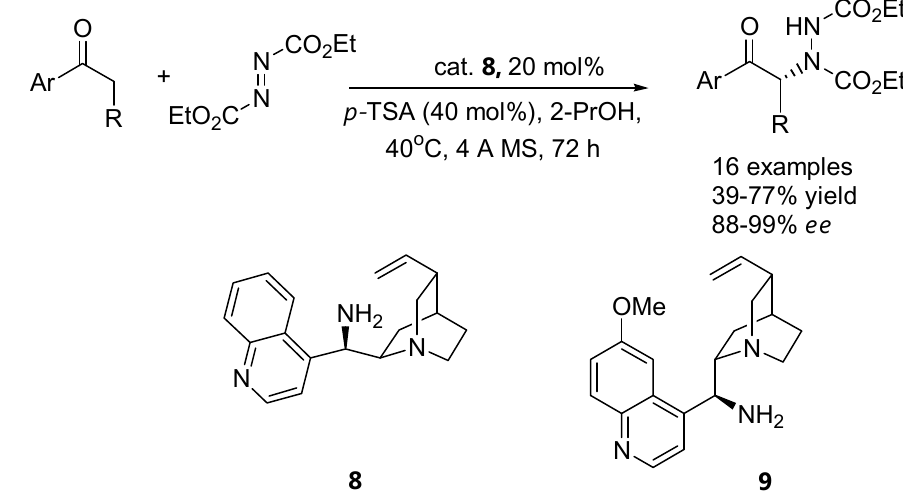
Figure 8. Various catalysts for direct  -amination of 1,3-dicarbonyl